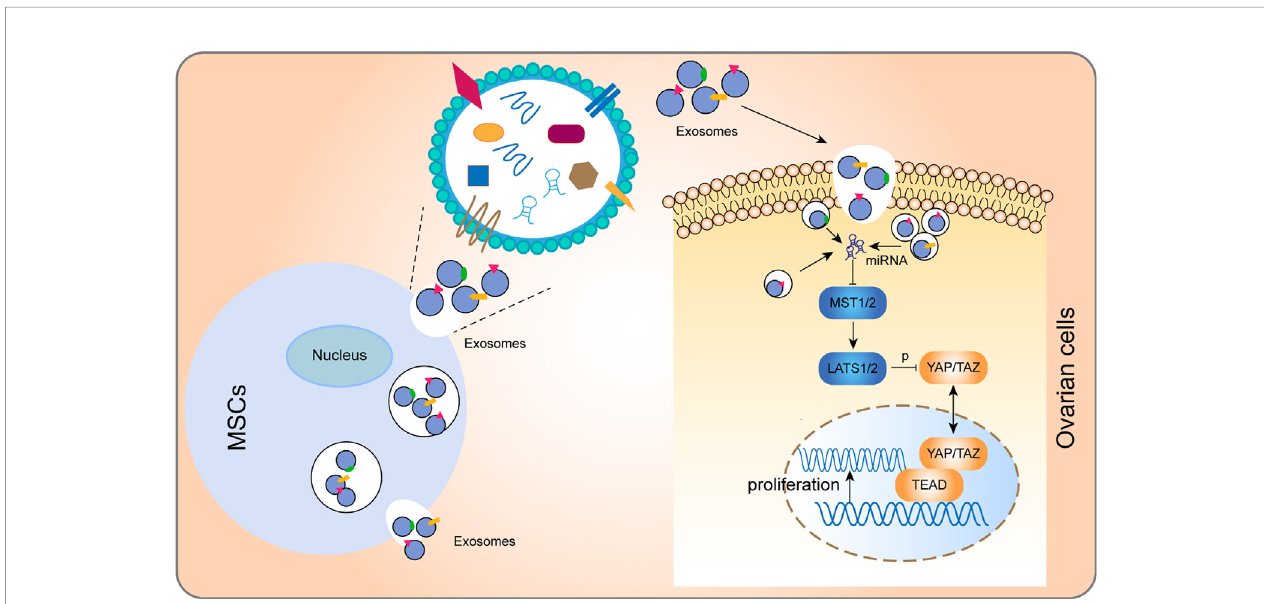
FIGURE 8 | Model for how hUCMSC-Exos increase ovarian cells proliferation by regulating the Hippo pathway. In brief, after phagocytosis by ovarian cells, exosomes regulated key molecules of the Hippo through the non-coding RNA and other molecules that they convey to cells, thereby regulating the Hippo pathway and promoting cell